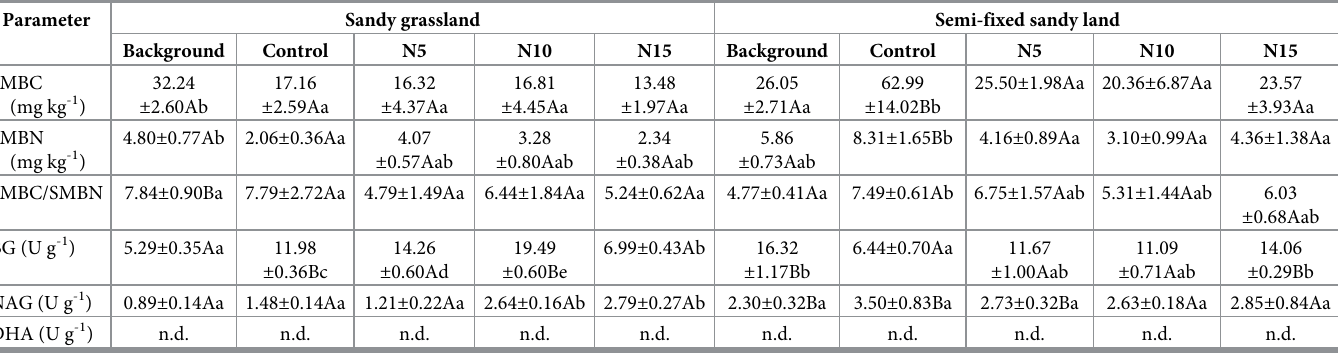
Table 2. The soil microbial biomass indices (soil microbial biomass carbon (SMBC), soil microbial biomass nitrogen (SMBN), and SMBC/SMBN ratio) and soil enzyme activities ( β -1,4-glucosidase (BG), soil N-acetyl- β -D-glucosidase (NAG), and soil dehydrogenase activity (DHA)) in the topsoil (to a depth of 20 cm) in the sandy grassland and semi-fixed sandy land.